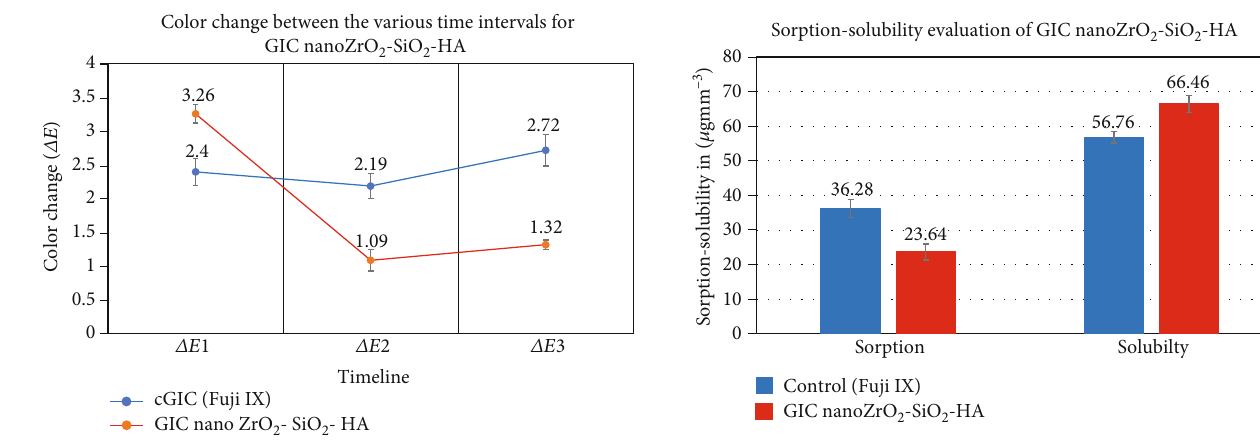
Figure 5: Graphical representation of sorption- solubility between GIC 5% nanoZrO